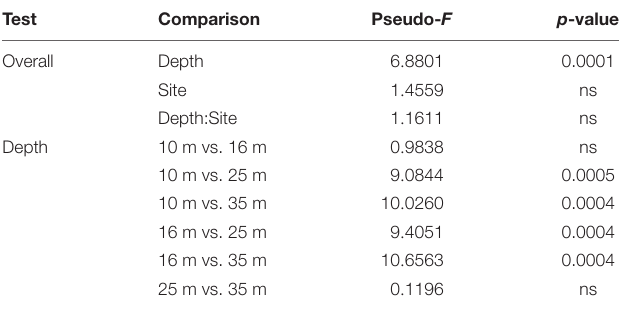
TABLE 3 | Test results from permutational multivariate analysis of variance (PERMANOVA; 9,999 permutations) of Symbiodiniaceae ITS2 type profiles from M. cavernosa colonies and pairwise comparisons between all depth zones (FDR